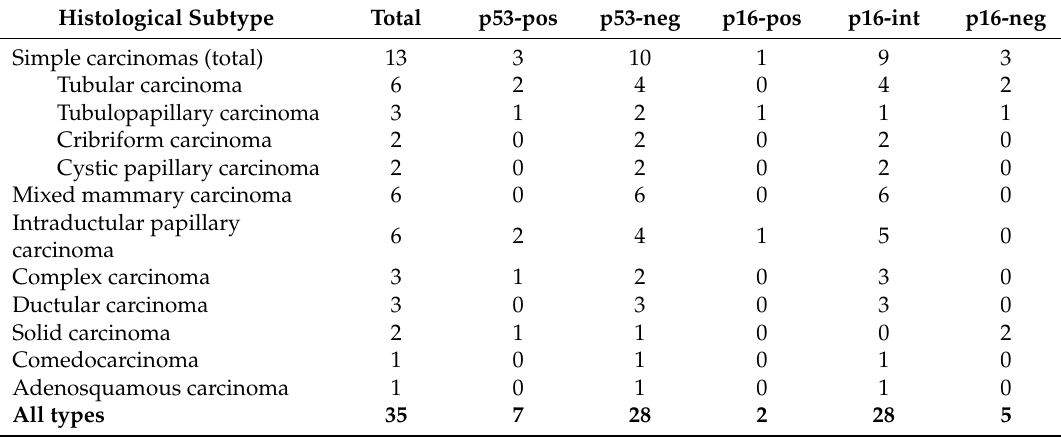
Table 1. Summary of p53 and p16CDKN2A protein (p16) immunostaining observed within the different histological types of canine malignant mammary gland